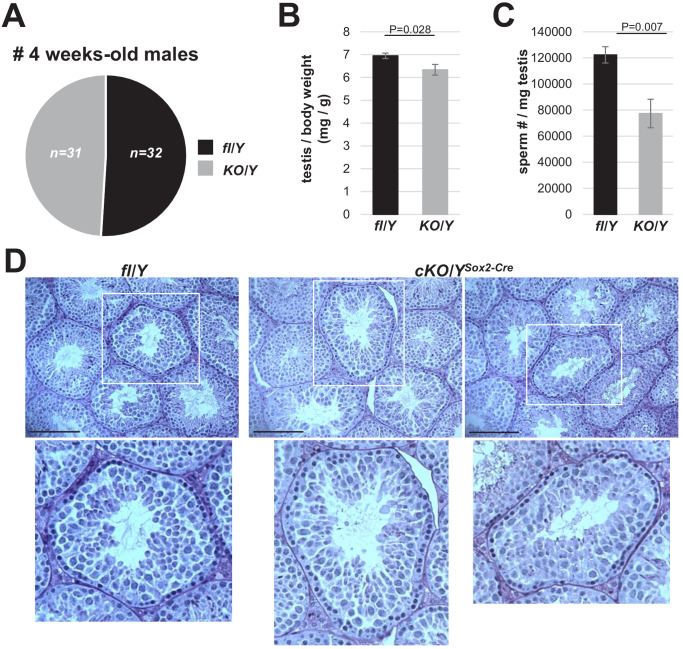
Decreased sperm production in males lacking Rlim.(A) Rlim has no essential functions during male embryogenesis and post-natal development. Using Rlimfl/KO as dames, a similar number of males out of 9 litters receiving a germline KO or the fl Rlim allele were born and appeared healthy beyond 4 weeks of age. (B) Significantly decreased weight of testes isolated from 8 weeks old cKO/Y animals (n = 8) when compared to fl/Y littermates (n = 6). Values were normalized against total body weight and represent the mean ± s.e.m. p Values are shown (students t-test). (C) Significantly decreased numbers of sperm in animals lacking Rlim. Cauda epididymal sperm were collected via swim-out in HTF medium. After 10 min of swim-out, total sperm numbers were determined (n = 6 fl/Y; n = 9 cKO/Y). s.e.m. and p Values are indicated. (D) No major difference in seminiferous tubules at step nine between fl/Y and cKO/YSox2-Cre in PAS-stained testes sections. Scale bars = 150 μm.